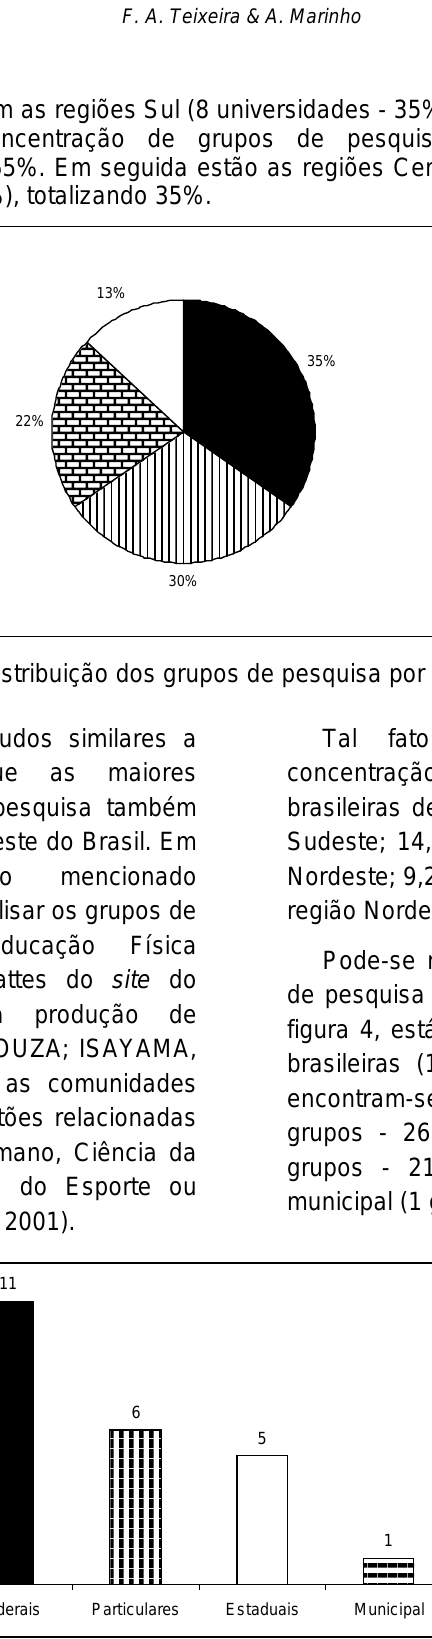
Figura 4. Distribuição dos grupos de pesquisa nas instituições de ensino superior no Brasil. Quando se trata da titulação dos líderes e vice-líderes que comandam os grupos de pesquisa,